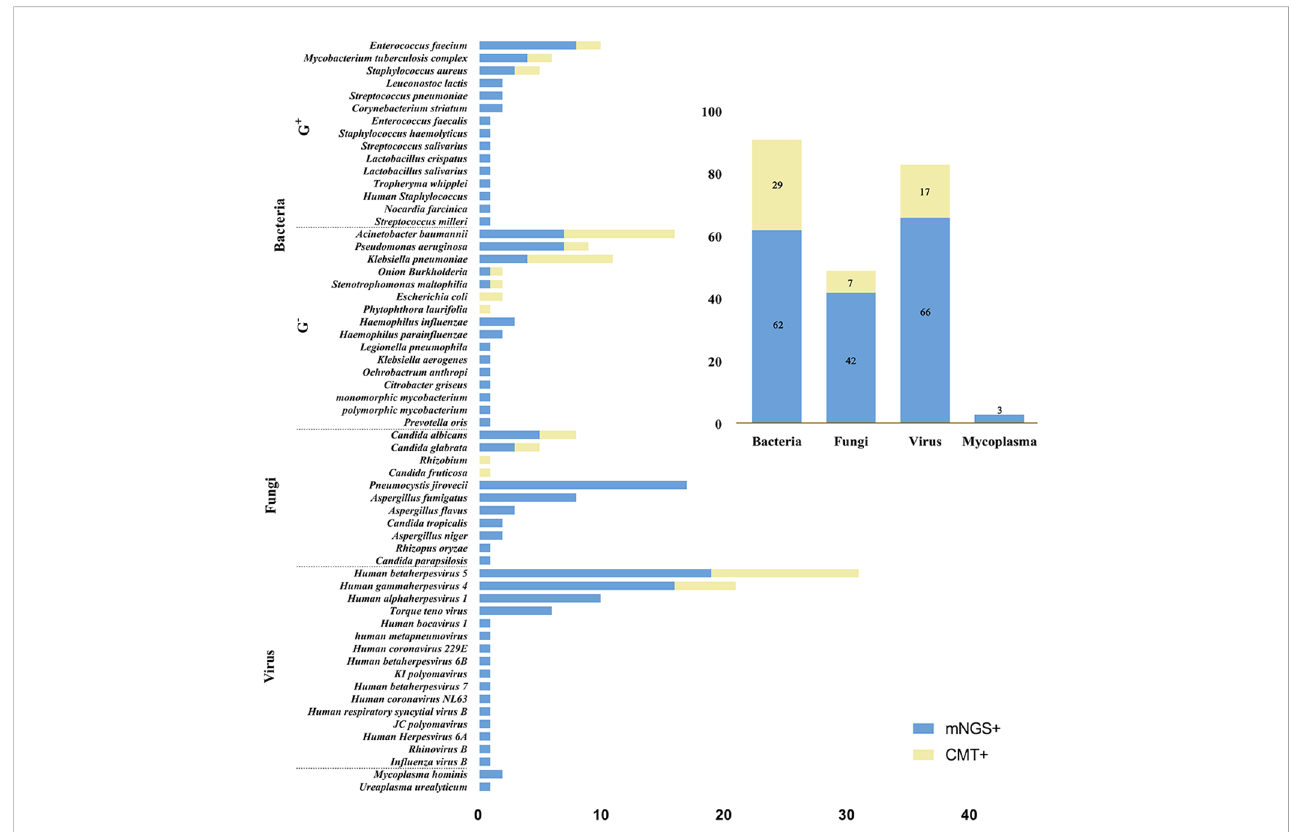
FIGURE 3 Microbial distribution bar charts. The left bar chart shows the distribution of all microorganisms detected by mNGS and CMT, and the top right bar chart shows the distribution of each type of microorganism. mNGS, metagenomic next-generation sequencing; CMT, conventional microbiological tests; G + , Gram-positive bacteria; G - , Gram- negative